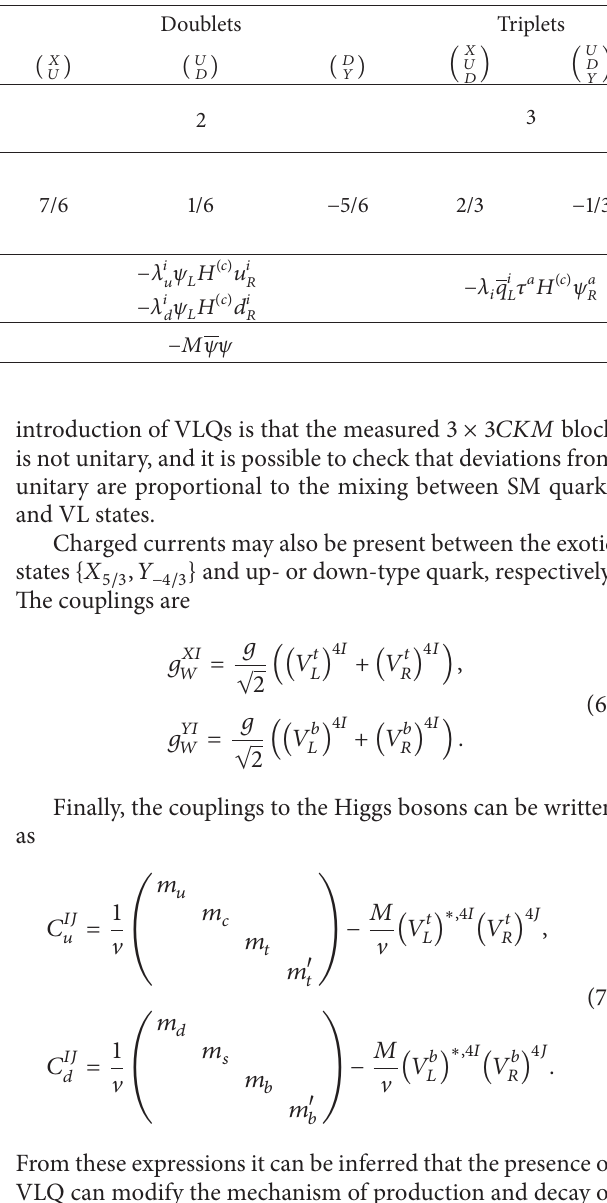
Table 1: Allowed representations for VLQs, with quantum numbers under 𝑆𝑈(2) 𝐿 and 𝑈(1) 𝑌 and Yukawa mixing terms in the Lagrangian. Depending on the chosen representation, the Higgs boson may be 𝐻 or 𝐻 𝑐 ; therefore it has been noted as 𝐻 (𝑐) when necessary. The gauge invariant mass term common to all representations is a peculiar feature of VLQs.